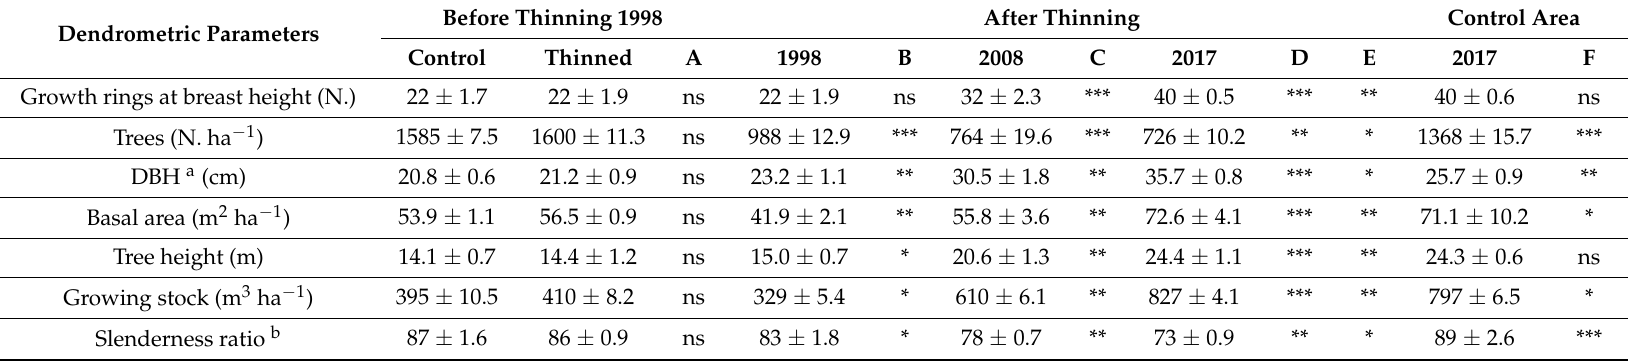
Table 1. Dendrometric parameters before and after thinning (1998; 2008; 2017) (mean ± SD). Before Thinning 1998 Dendrometric Parameters Growth rings at breast height